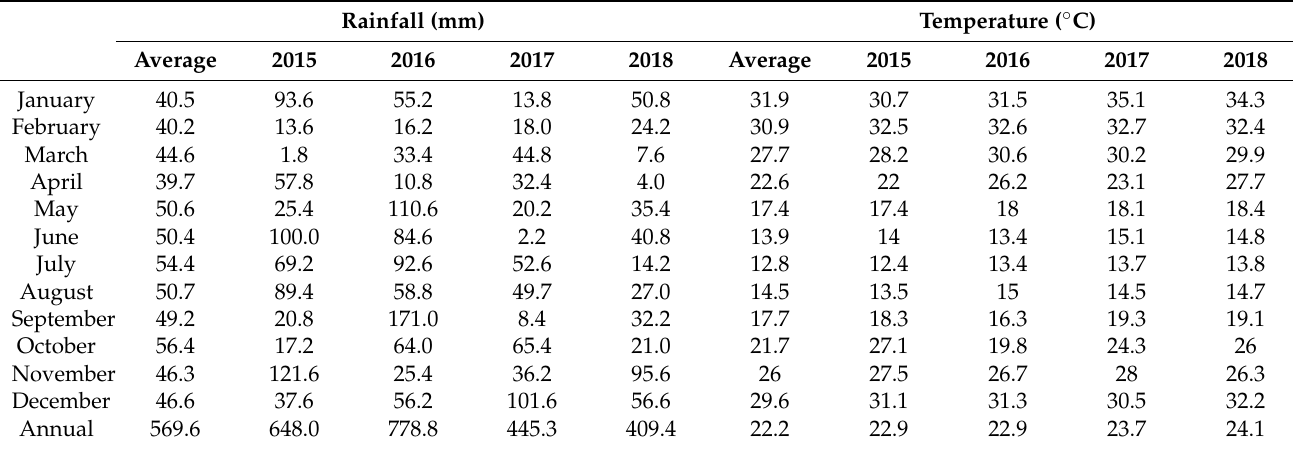
Table 3. Monthly long-term average rainfall and temperature and rainfall and temperature during the experimental period at the Wagga Wagga Airport Meteorological Office (Australian Bureau of Meteorology). Rainfall (mm) Temperature ( ◦